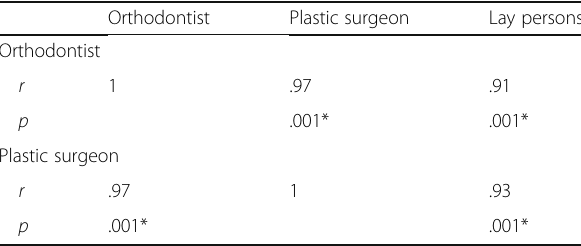
Table 3 Evaluation of correlations among the groups Orthodontist Plastic